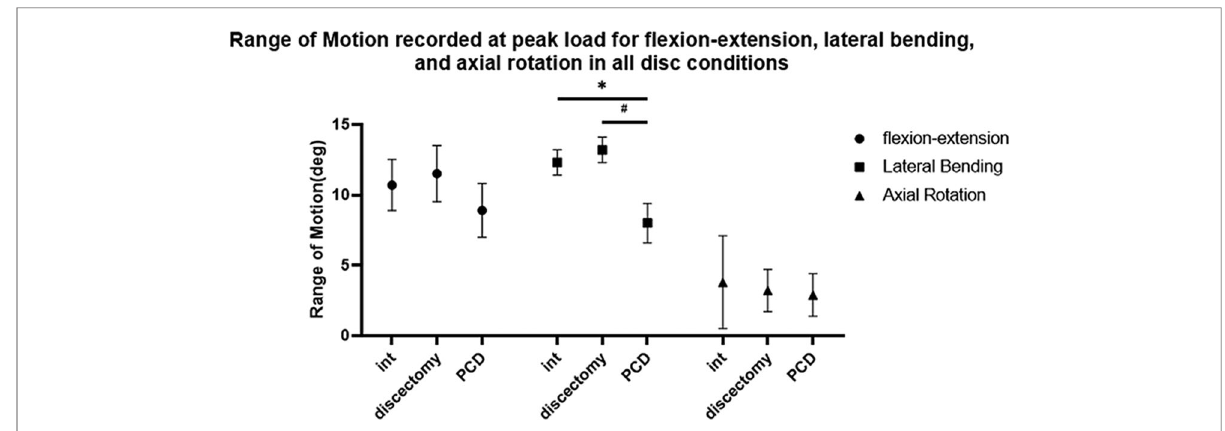
FIGURE 5 ROM values for different conditions ( n =8, ±SD, degree, °). * P <0.05: compared with the Int group; # P <0.05: compared with the nucleotomy group.